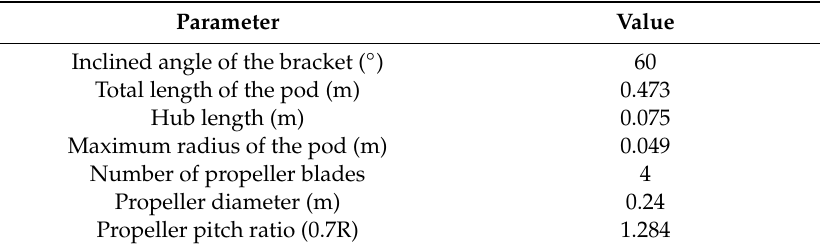
Table 1. Basic parameters of the podded propulsor.